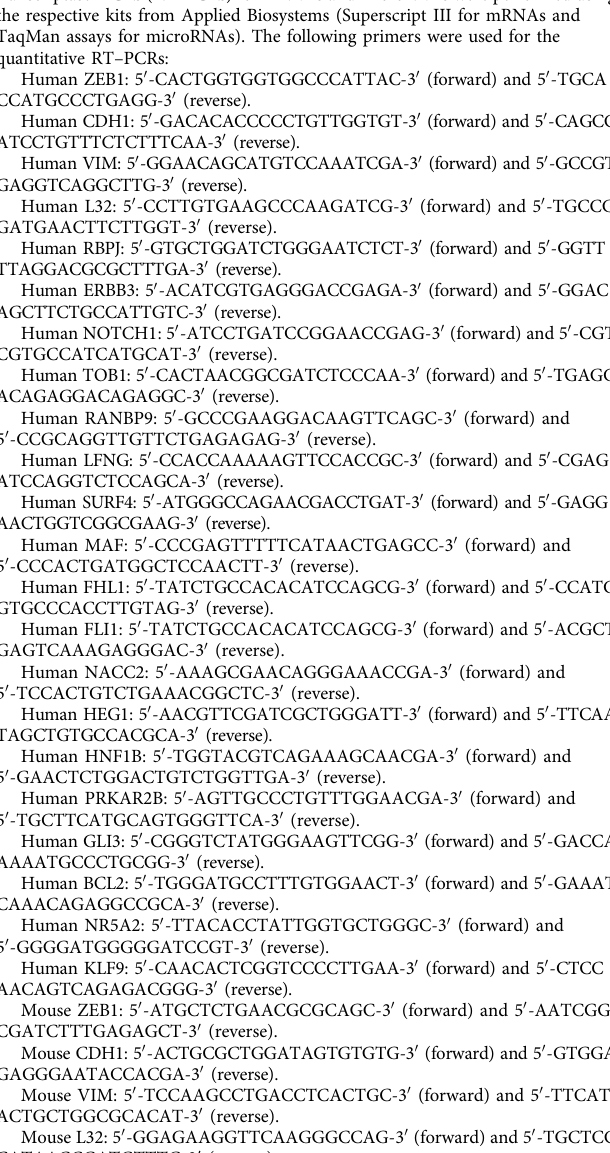
incubated with fresh protein lysates and anti-phospho-tyrosine antibody (provided by the kit). Phosphorylated-RTK spots were then visualized by incubating with ChemiReagent provided by the kit as instructed by the product manual. Western blotting . Whole-cell protein extraction was performed by lysing in RIPA lysis buffer system (Santa Cruz). The extracted proteins (10–30 m g) were separated by SDS–PAGE electrophoresis, transferred onto polyvinylidene difluoride membranes, blocked with 5% skim milk and incubated with primary antibodies overnight. Protein bands were visualized by incubating with an